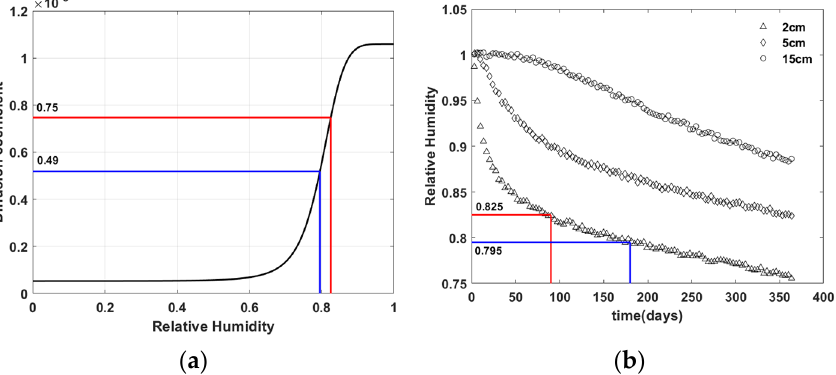
Figure 16. Relative humidity range corresponding to observation period in virtual experiment with material M1—( a ) moisture diffusion model D; ( b ) relative humidity distribution over time.